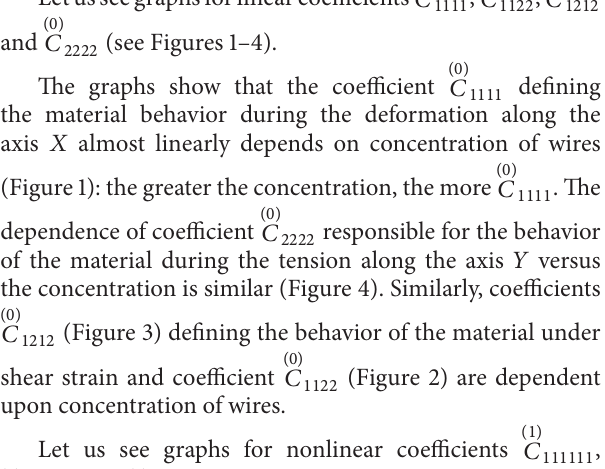
Figure 4: Dependence of coefficient versus concentration of reinforcing wires.